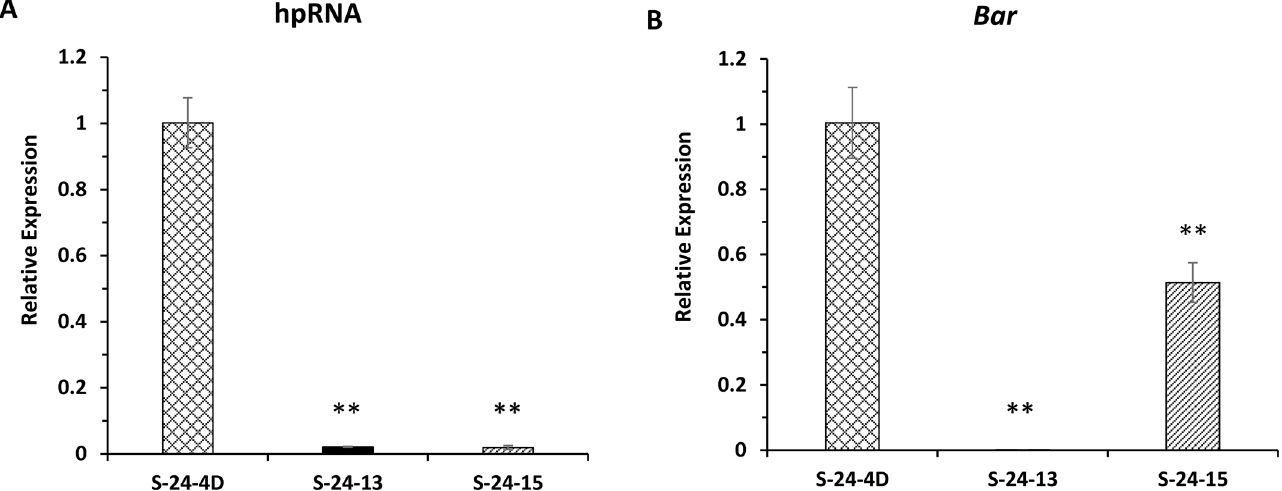
Fig 2. hpRNA and bar transcript level of pMUFAD homozygous lines. Data are averages of biological triplicates ± SD normalized to CONS7 mRNA. Independent-Samples T Test was used to test the significance. Asterisks indicate significant differences in relative expression ( * p < 0.05, ** p < 0.01). S-24- 4D, S-24-13, and S-24-15 are T 5 homozygous for the pMUFAD transgene. Soybean cultivar Jack is used as wild-type control. (A) and (B) Normalized transcript level of hpRNA and bar , respectively. The values of S-24-4D plants were arbitrarily fixed to 1.0.